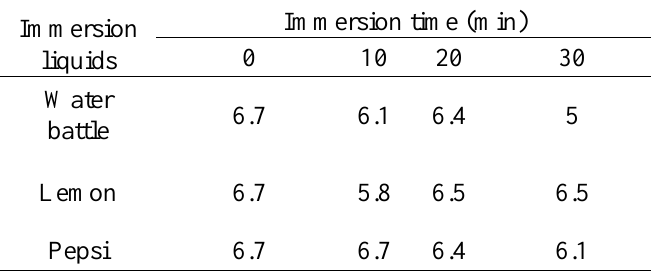
Table 2: Impact strength (I.S.) of pure PMMA for (10, 20, 30 min) immersed in (Mineral water, Lemon and Pepsi).